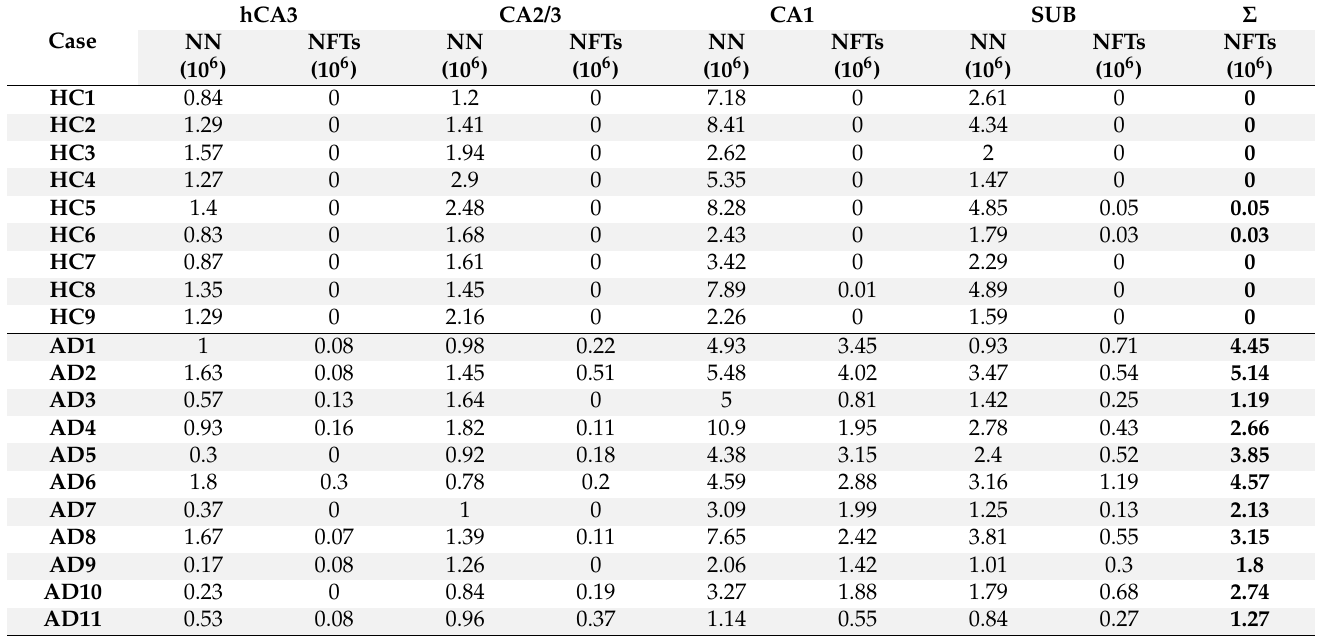
Table 4. The total number of neurons (NN) and neurofibrillary tangles (NFTs) in hippocampal formation domains in HC and AD